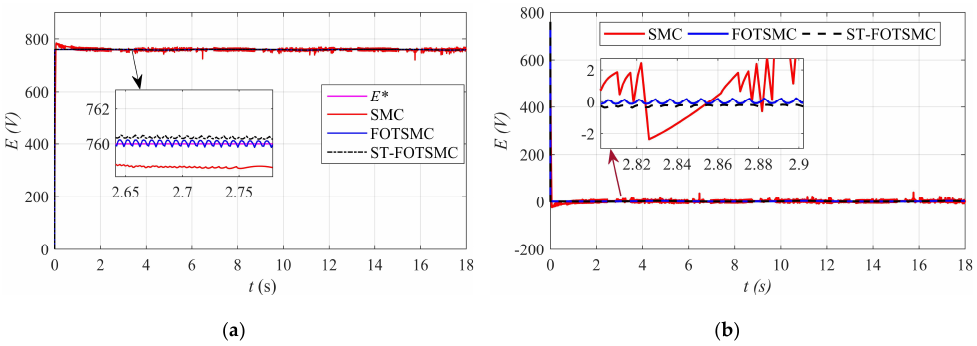
Figure 14. ( a ) DC-link voltage; ( b ) voltage error under lumped uncertainties.